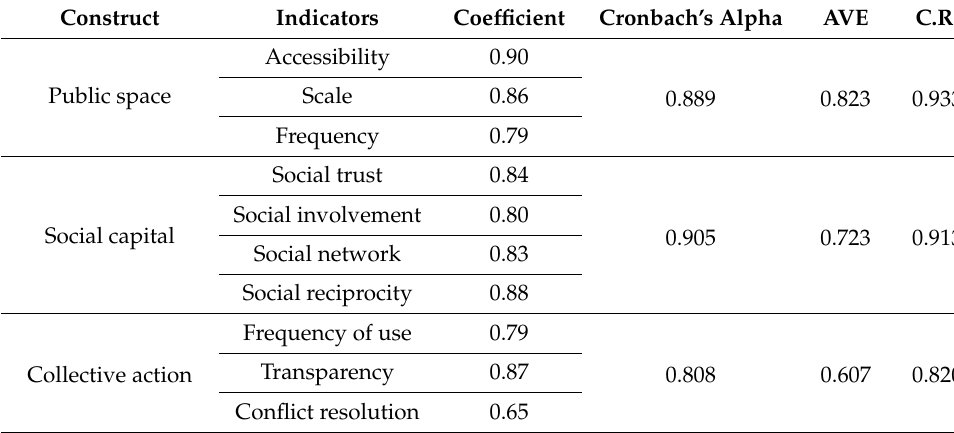
Table 4. Estimation results of the measurement